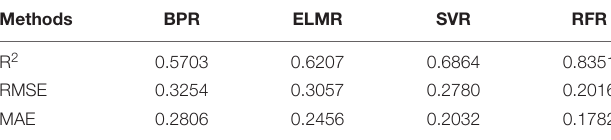
TABLE 7 | The R 2 , RMSE and MAE of the test set.